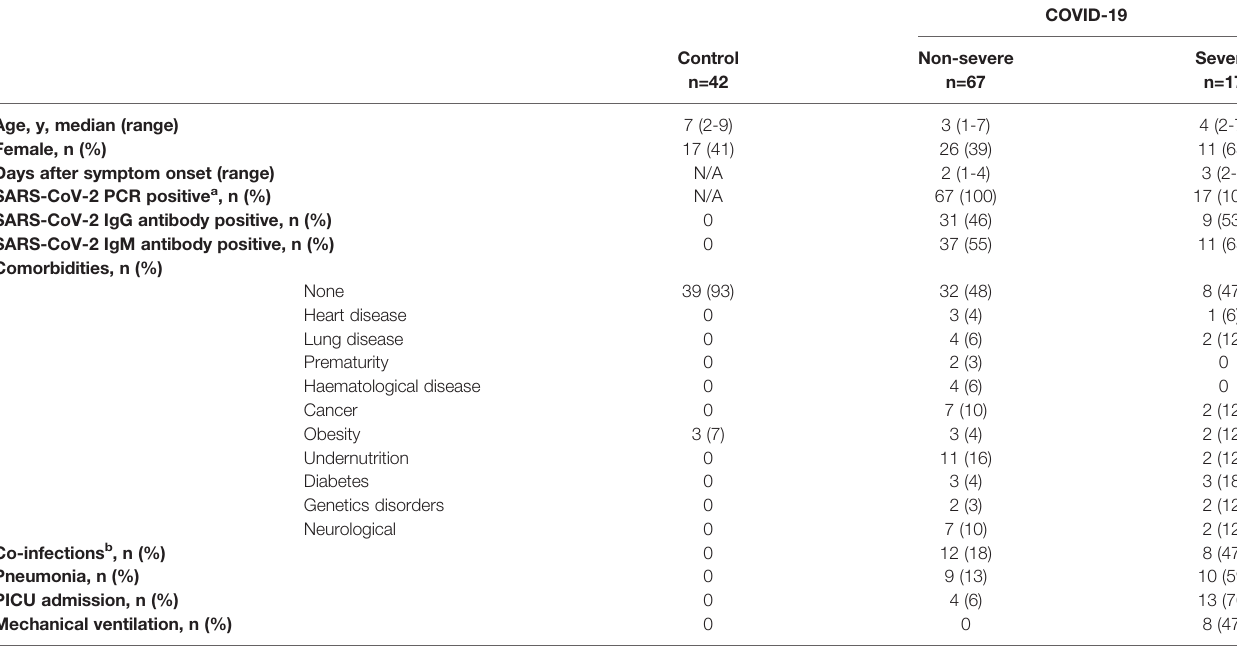
TABLE 1 | Characteristics of children with COVID-19 and healthy